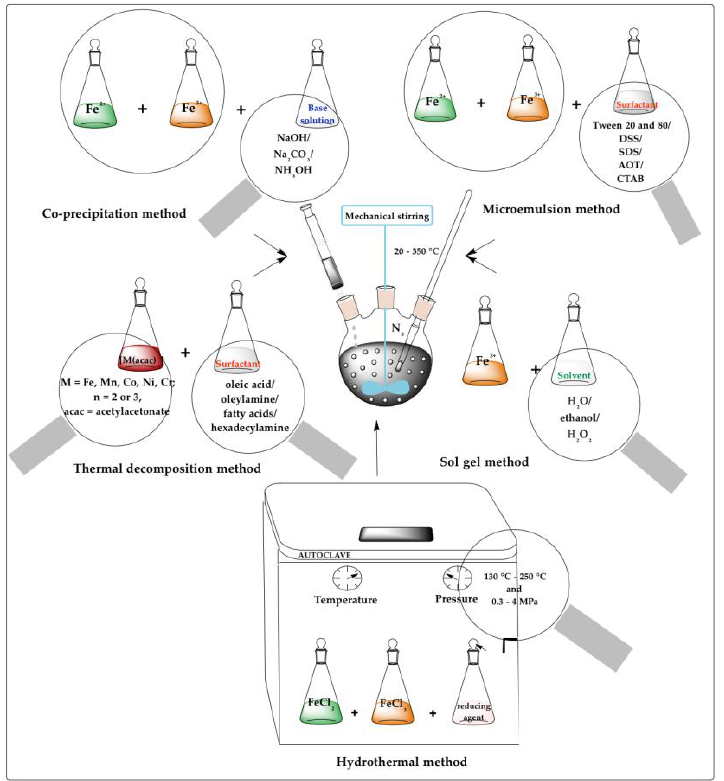
Figure 1. Techniques for synthesis of iron oxide core for imaging purposes.